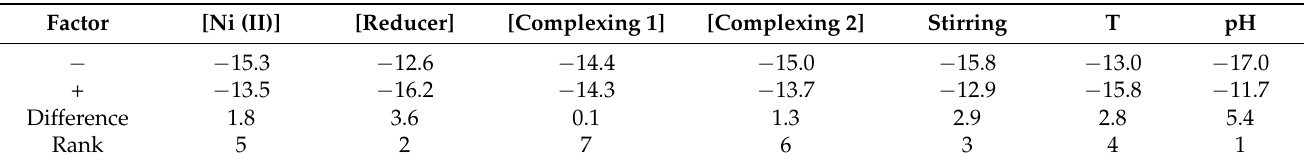
Figure 1. Signal-to-noise (S/N) ratios for ( a ) P content, ( b ) thickness, ( c ) hardness, ( d ) wear resistance (worn volume), and ( e ) corrosion resistance (corrosion current) of electroless nickel plating (ENP) layers for the differently analyzed factors and their levels ( − , +). Table 3. Mean effect plot for S/N ratios for P content in the ENP layers obtained following the lower-the-better optimization approach.